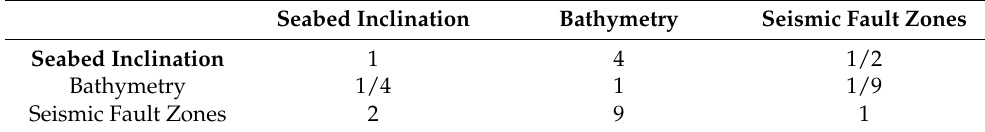
Table 2. Qualitative prioritization for Case Study 1 with a consistency ratio equal to